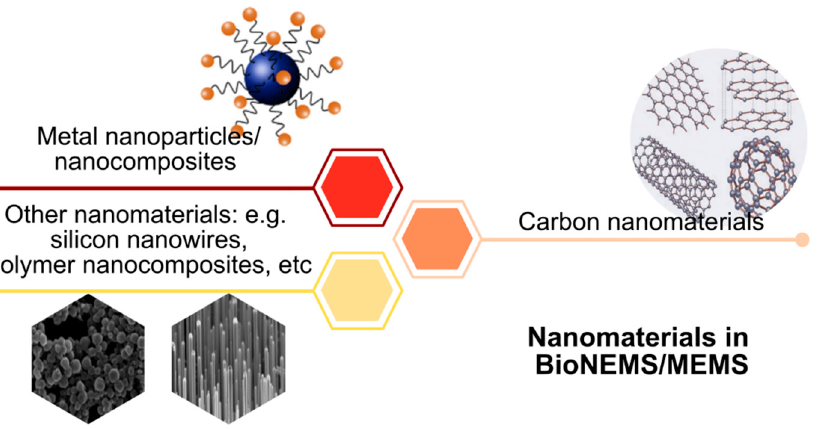
Figure 2. Types of inorganic nanomaterials developed using bioNEMS/MEMS techniques for biomedical applications.